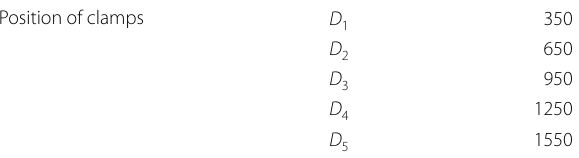
Table 1 Original parameters of clamp locations (mm)